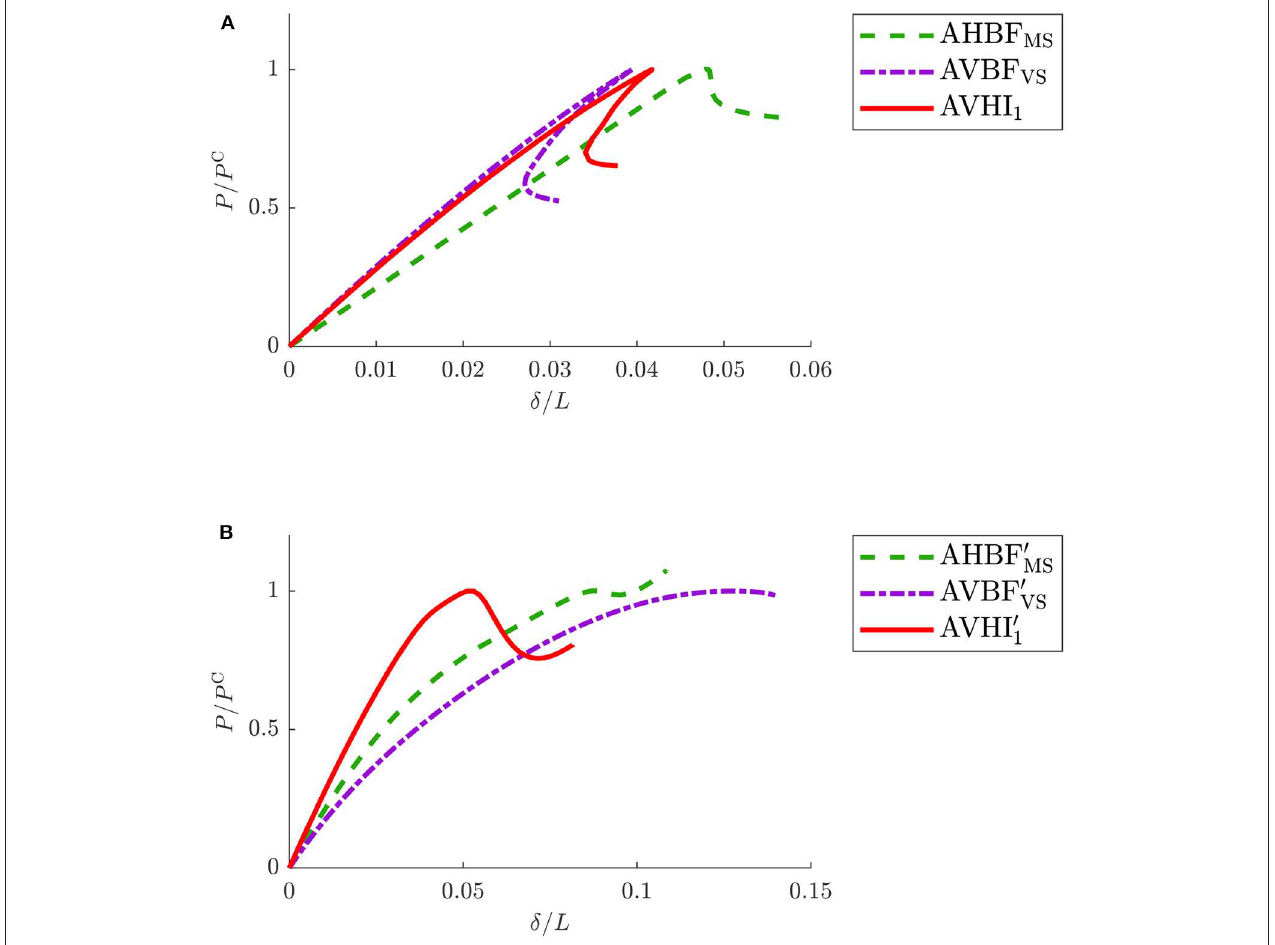
FIGURE 11 | Normalized load P / P C vs. normalized end-shortening δ/ L behavior for the three lattice core cases with disruptions where: (A) AVHI 1 , AHBF MS and AVBF VS are with midspan face plate elements and (B) AVHI ′ 1 , AHBF ′ MS , and AVBF ′ VS are with midspan face plate elements omitted.